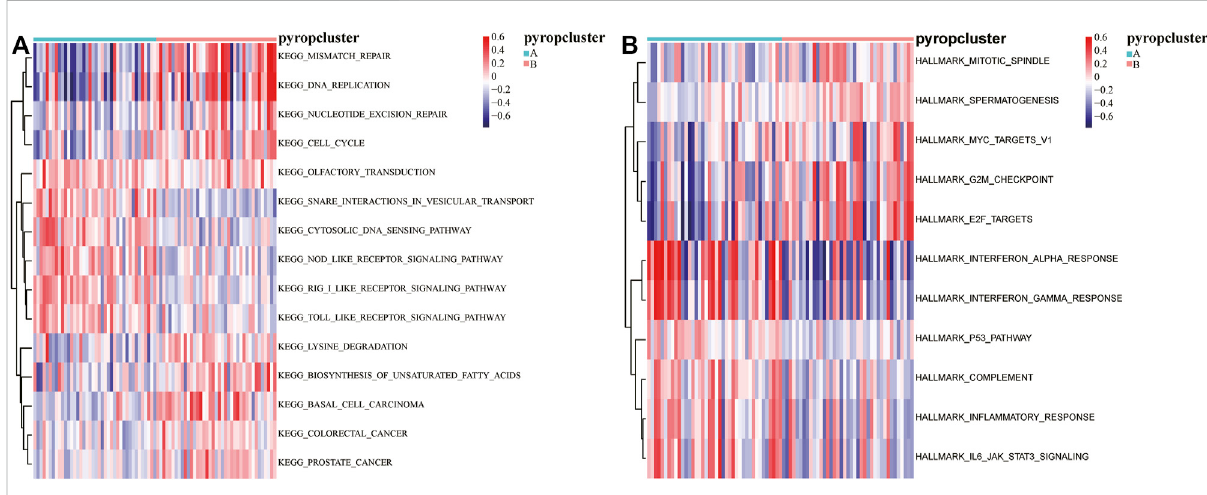
FIGURE 5 GSVA based on DEGs between the pyroptosis subtypes. (A) The enrichment of KEGG pathways in GSVA, red indicates activation and blue indicates inhibition. (B) The enrichment of HALLMARKs in GSVA, red indicates activation and blue indicates